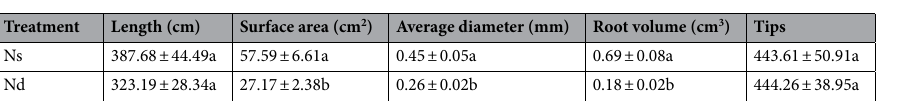
Table 1. Effects of nitrogen-sufficient and nitrogen-deficient conditions on burley tobacco root morphology. Values followed by lowercase letters in the same column are significant by different treatments at a probability level of 0.05. Ns nitrogen-sufficient conditions, Nd nitrogen-deficient